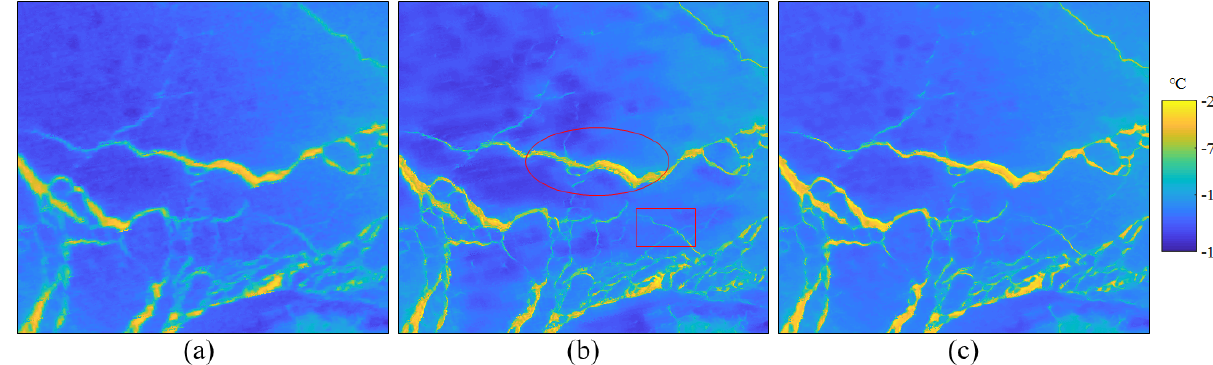
Figure 16. Results of the MODIS SR IST imaging for data acquired on 31 March 2020 obtained by (a) the cubic interpolation method, (b) the CNN model with the backbone of the CNN used in SR lead mapping, and (c) the very deep residual CNN model. The red rectangles represent that the fine spatial pattern has been recovered by the multi-level feature fusion residual CNN. The red ellipses represent the recovered surface temperatures of lead pixels by the multi-level feature fusion residual CNN that were not visually